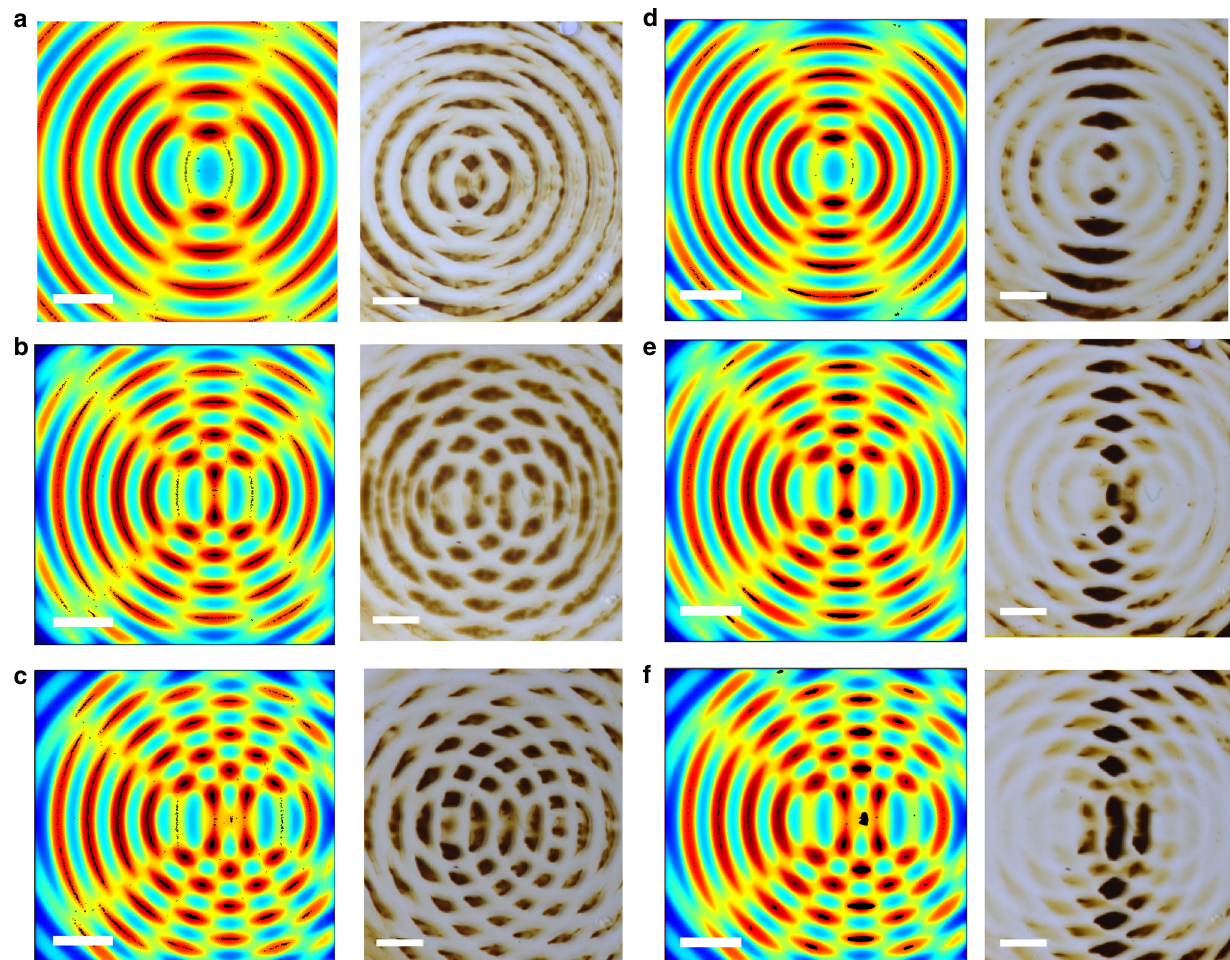
Fig. 4 “ Focusing ” of magnetic particles upon motion of the fi eld-templating grids. The patterns form between two stamps, each presenting an array of concentric magnetic circles. In a – c the circle arrays are immediately placed in the orientations shown. In d – f , they are fi rst put on top of one another, and then one stamp is slowly moved sideways. Experimental images are accompanied by the results of MD simulations showing fi eld intensity and distribution of particles (black spots in fi eld maxima). Also see Supplementary Movie 4 visualizing the motions of particles in MD simulations. Scale bars in simulation and experimental images are 100 μ m and 2 mm,